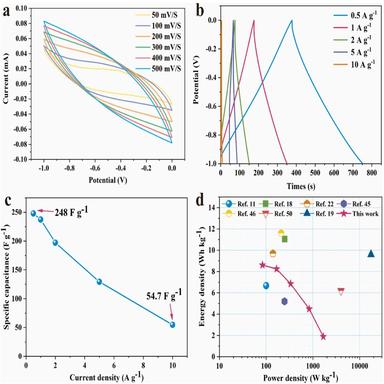
Electrochemical tests of SPCM with a two-electrode device. (a) CV curves (the scanning rates of 50–500 mV s − 1 ), (b) GCD curves (the current densities of 0.5–10 A g− 1 ), (c) specific capacitances with different current densities for SPCM, (d) Ragone diagram of SPCM as symmetrical electrodes and comparison with previous literature on energy and power densities.